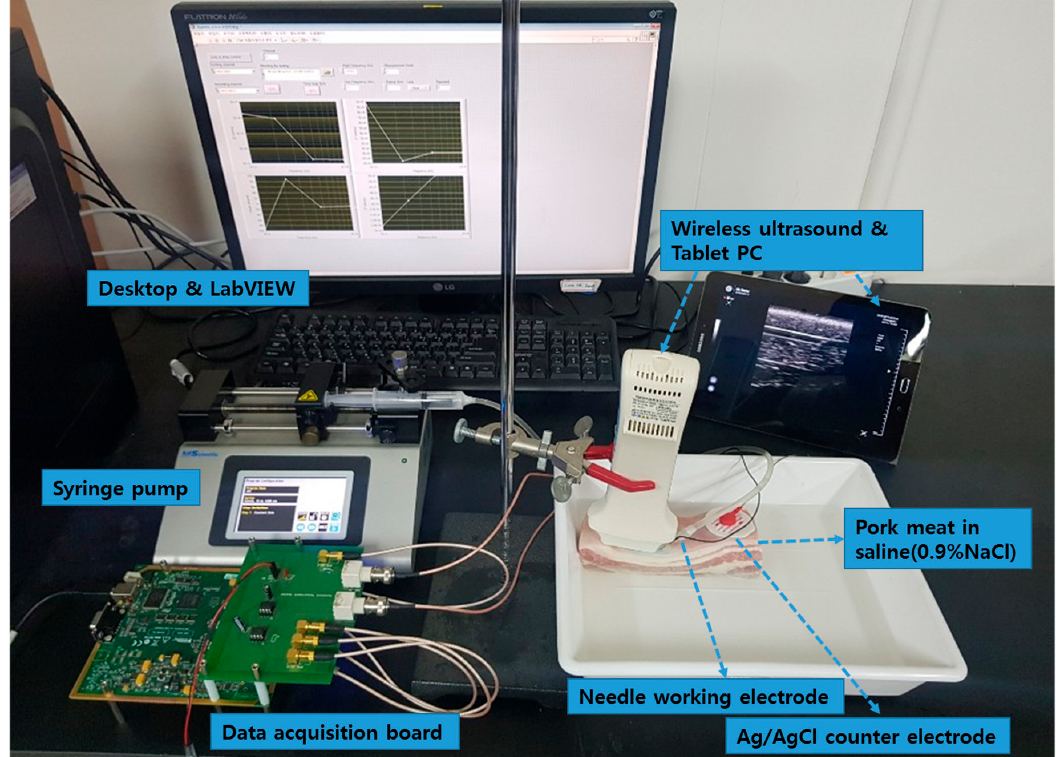
Figure 1. Experimental setup of the lock-in amplifier (LIA)-based impedance measurement system for detection of the tip position of the monopolar injection needle in the tissue layers with Ag/AgCl counter electrode and saline injection with the syringe pump and ultrasound (US) device.